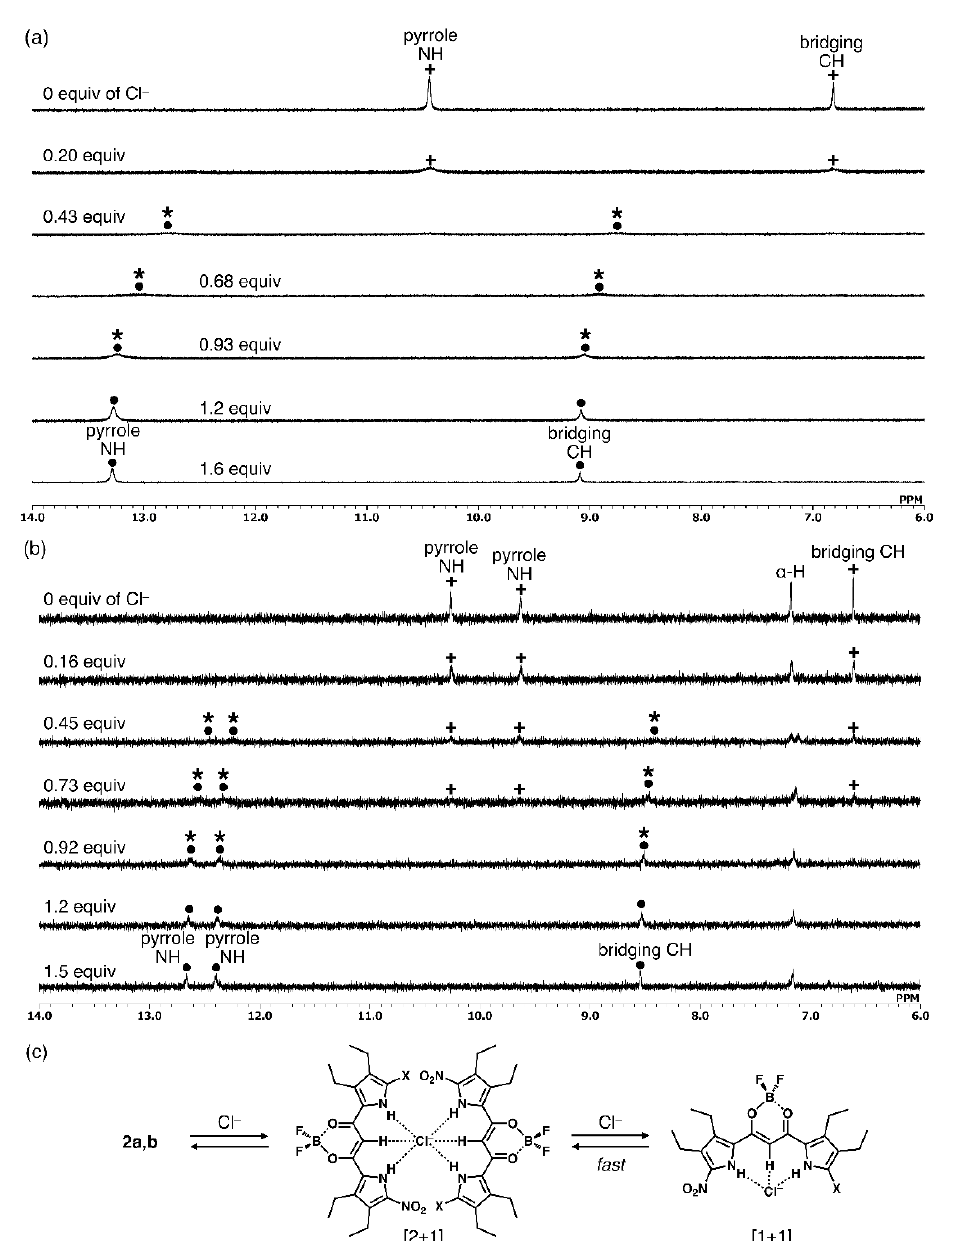
Figure 7. 1 H-NMR spectral changes of ( a ) 2a and ( b ) 2b in CD 2 Cl 2 (1.0 mM) at −50 °C upon the addition of Cl − as a TBA salt and ( c ) possible anion-binding modes of 2a , b (X = NO 2 and H, respectively). In ( a , b ), the signals of anion-free receptors, [1+1]-type, and [2+1]-type complexes are labeled with plus, circle, and asterisk marks, respectively.